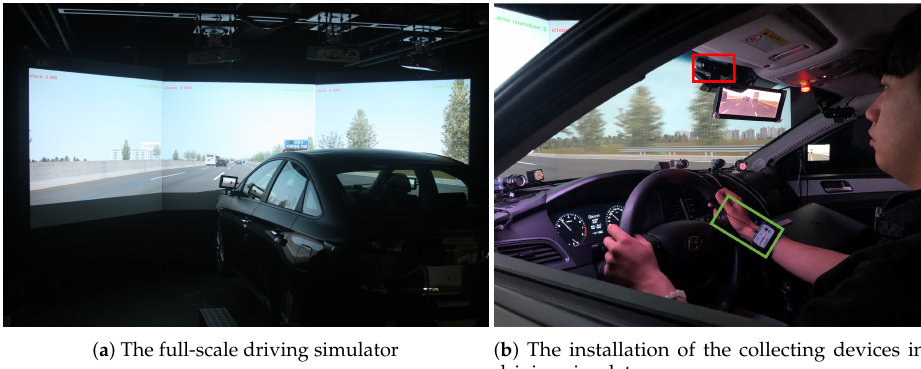
Figure 7. ( a ) Three-channel projectors and screens and the cabin of the full-scale driving simulator. ( b ) The camera is installed between the windshield and the headliner (red) and the biomedical instrument is set on the driver’s wrist for EDA